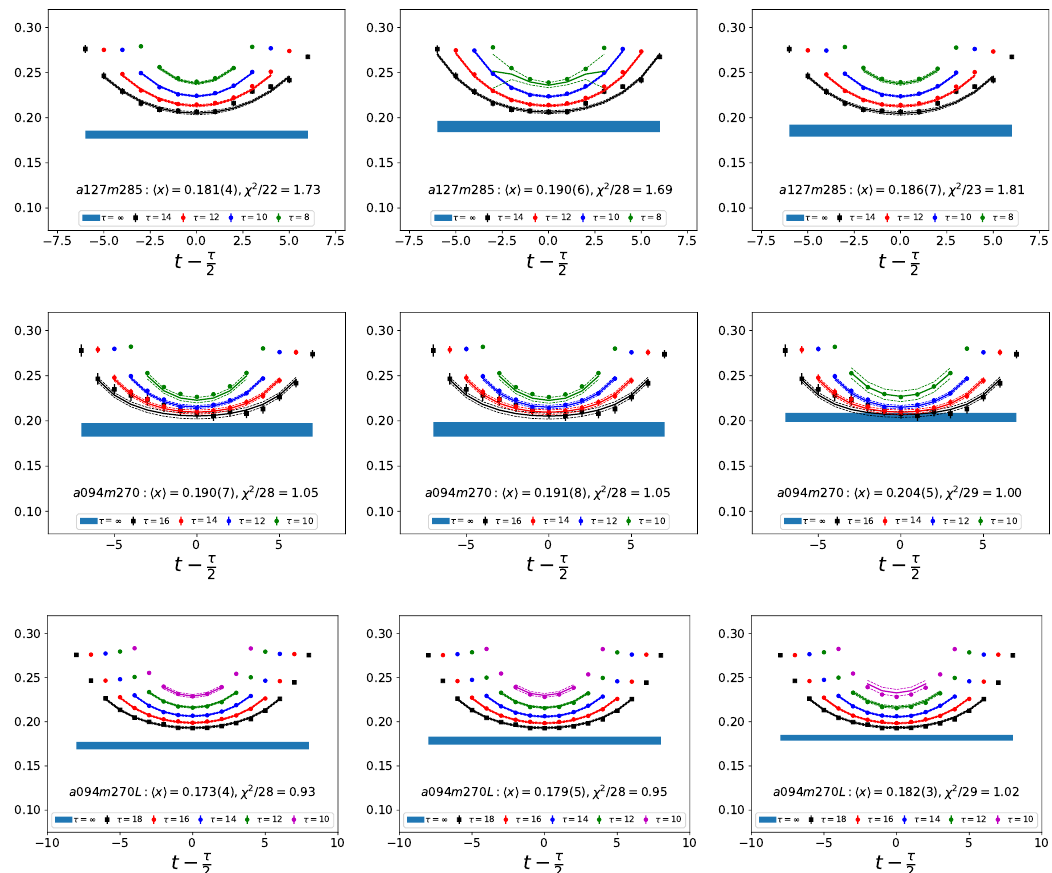
Figure 5 . Data and fits to remove excited-state contamination in the extraction of the momentum fraction h x i for a 127 m 285 (top row), a 094 m 270 (middle row), and a 094 m 270 L (bottom row) u − d ensembles. The data for the ratio C 3 pt ( τ ; t ) /C 2 pt ( τ ) is scaled using eq. (3.8) to give h x i O the fit parameters are listed in tables 7. In each row, the three panels show fits to the data with the largest three values of τ using the three strategies: { 4 Nπ , 3 ∗ } (left), { 4 , 3 ∗ } (middle) and { 4 , 2 free } (right). For each τ , the line in the same color as the data points is the result of the fit used (see section 5) to obtain the ground state matrix element. The result for the unrenormalized ground- state value of the moment is shown by the blue band and summarized in table 6 along with the values of t used in the fit. The y-interval is selected to be the same for all the panels to facilitate skip